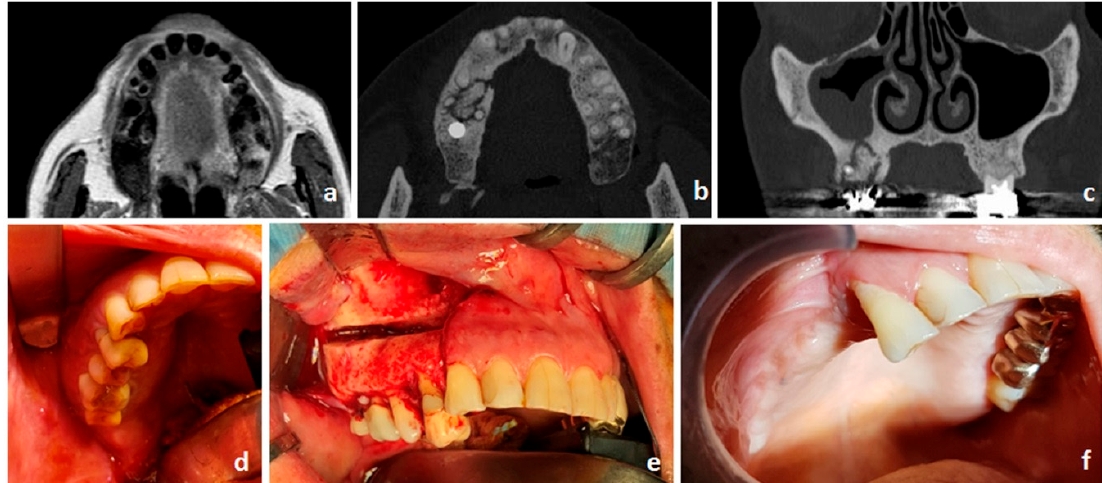
Figure 4. Clinical aspect of non-exposed bone variant of ONJ. The same patient from Figure 3 did not complete the recommended periodontal evaluation of dental elements of the upper right jaw. She developed a recurrent upper dental abscess, with swelling of the right cheek. This is a clinical manifestation of the non-exposed bone variant of ONJ. ( a ) Preoperative magnetic resonance imaging (MRI) showing high signal intensity of periodontal space in the right upper jaw. ( b ) Computed tomography (CT) scan in axial view showed large areas of increased medullary bone density of the upper dento-alveolar process. Bone sequestration was present close to periodontal disease. ( c ) CT scan in coronal view showed large areas of increased medullary bone density of the upper dento- alveolar process. Bone sequestration was present close to periodontal disease. Upper jaw involvement is related to a maxillary sinusitis. ( d ) Preoperative intraoral view with absence of exposed necrotic bone (unexposed variant of ONJ). ( e ) Intraoperative view of right partial upper maxillectomy. ( f ). Postoperative healed intraoral view. Primary closure of the surgical site was obtained by Bichat buccal fat pad transfer and mobilization of a muco-periosteal flap.